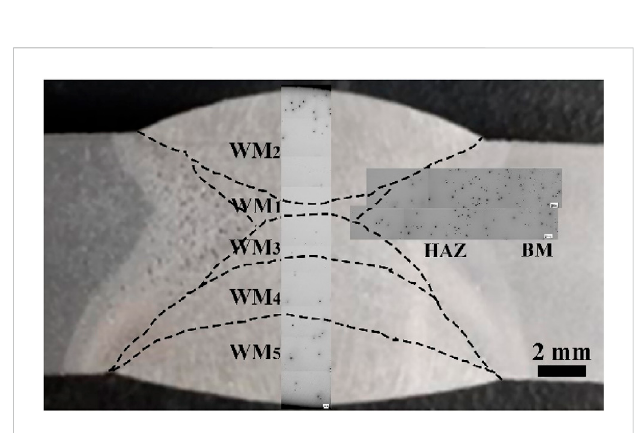
FIGURE 6 Metallographic morphology of the weld joint after